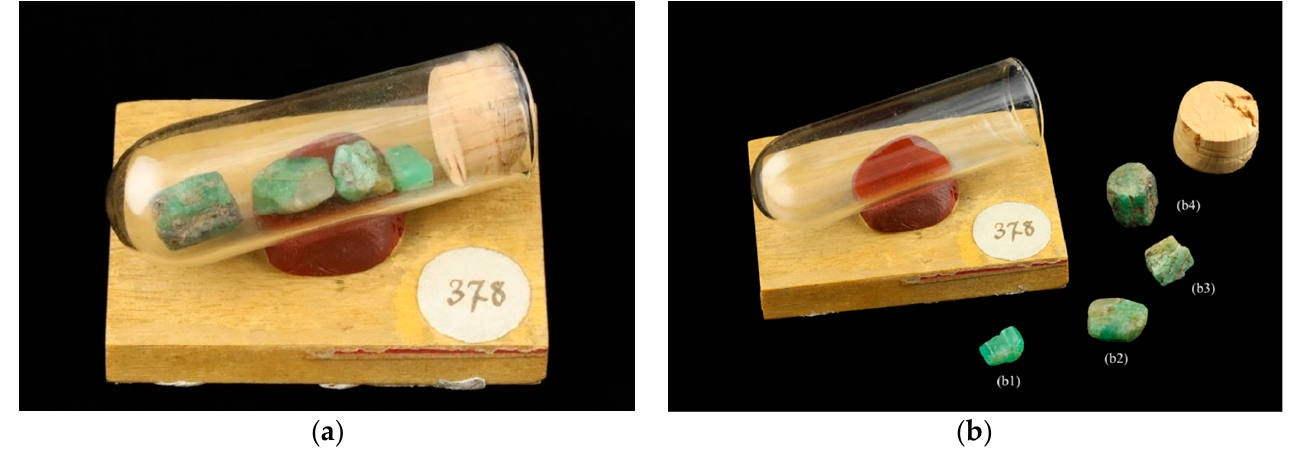
Figure 3. ( a , b ) Macroscopic images of Egyptian single-crystal emeralds from Ecole des Mines. ( b1 ) ENSMP 72466_01, ( b2 ) ENSMP 72466_03, ( b3 ) ENSMP 72466_02, ( b4 ) ENSMP 72466_04. Photos: